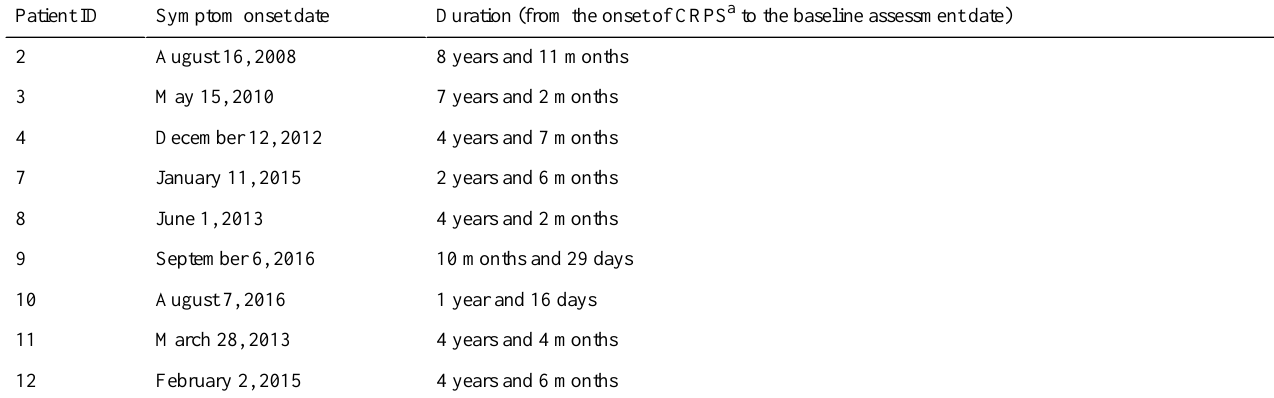
Table 1. Participants’CRPS symptom onset and